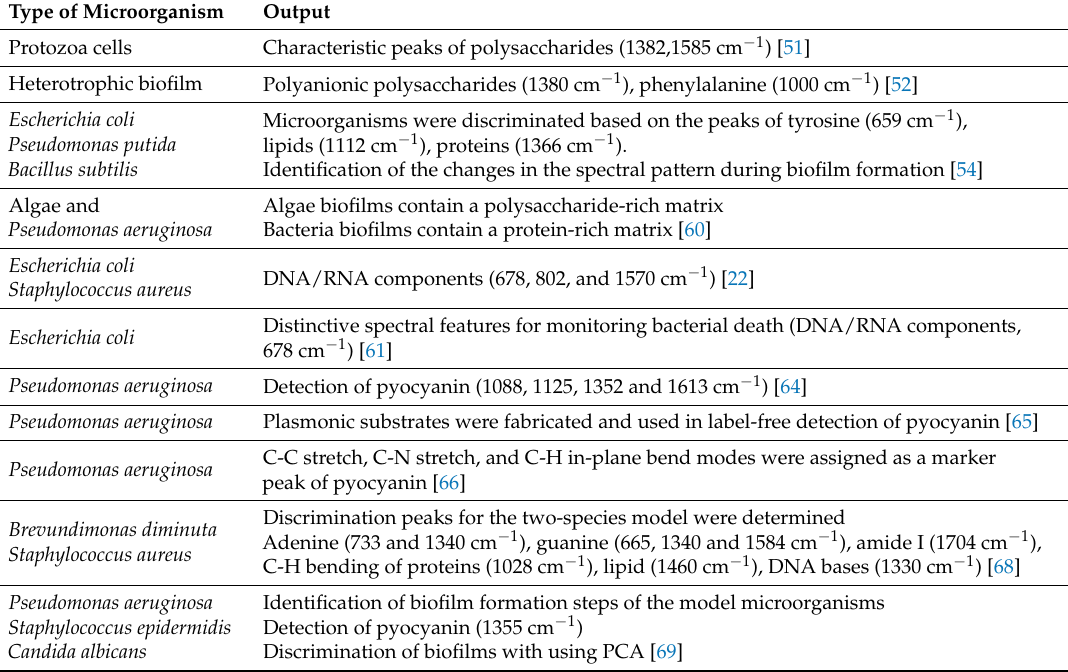
Figure 4. SERS spectra of biofilm formation of Pseudomonas aeruginosa at cultivation times between 4 and 120 h [69]. Table 1. A list of SERS studies mentioned in the “Surface-enhanced Raman scattering of biofilms” section.